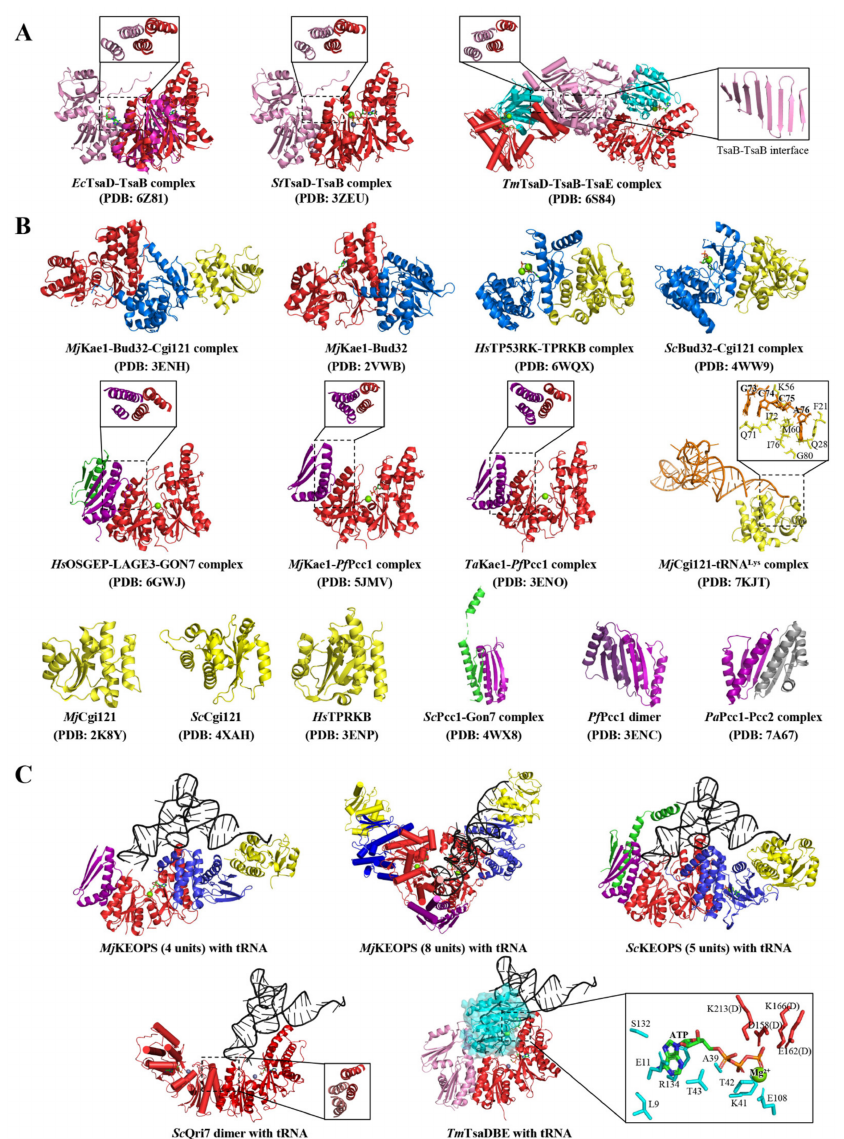
Figure 2. Structural assembly of tRNA t 6 A-modifying enzymes in the three domains of life. ( A ). Crystal structures of Ec TsaD–TsaB [36], St TsaD–TsaB [37] and Tm TsaD–TsaB–TsaE [87]. TsaD, TsaB and TsaE are colored in red, pink and cyan, respectively. In Ec TsaD–TsaB, an equivalent TsaB is structurally aligned to TsaD. The conserved “helical bundle” at the interacting interface between TsaD and TsaB is shown in the inserts. TsaB–TsaB interacting interface in Tm TsaD–TsaB–TsaE are shown in the insert. ( B ). Crystal structures of KEOPS subunits and subcomplexes from different species